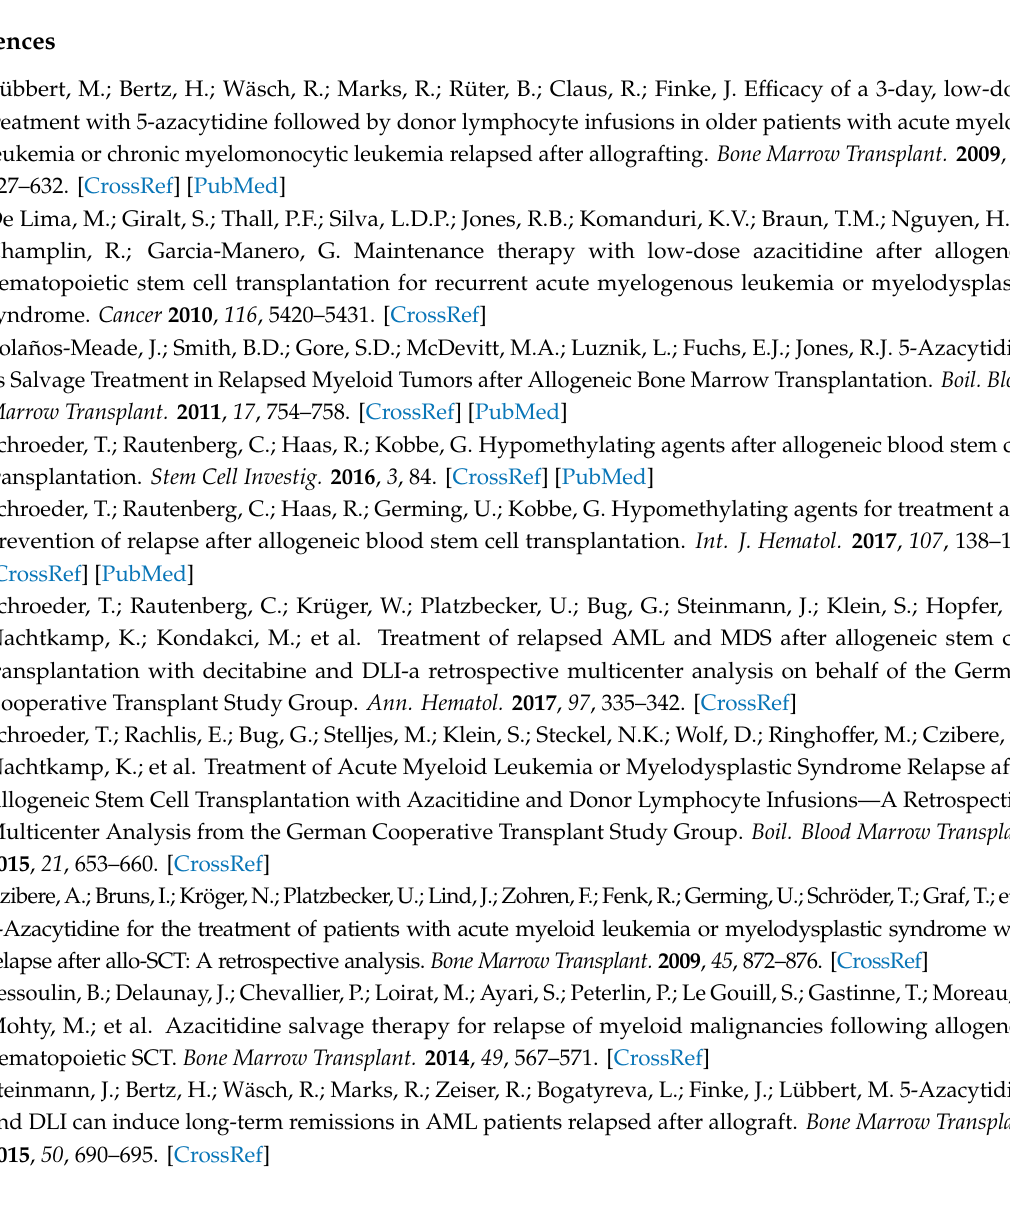
Figure S1: Landmarkanalysis regarding OS of patients who received DLI compared to those who did not; Figure S2: Overall survival (OS) after treatment with Azacitidine ± DLI in 77 patients with AML and MDS treated with Azacitidine / DLI for hematologic relapse after allo-HSCT according to the Aza Relapse Prognostic Score [11]; Table S1: Conditioning regimen; Table S2: Impact of Clinical Parameters on Response and Outcome after Treatment with Azacitidine for post- transplant sAML# and MDS relapse – Univariate and Multivariate Analysis (n = 66); Table S3: Two-year overall survival and response rate of 77 patients with AML and MDS treated with Azacitidine ± DLI for hematologic relapse after allo-HSCT according to the Aza Relapse Prognostic Score